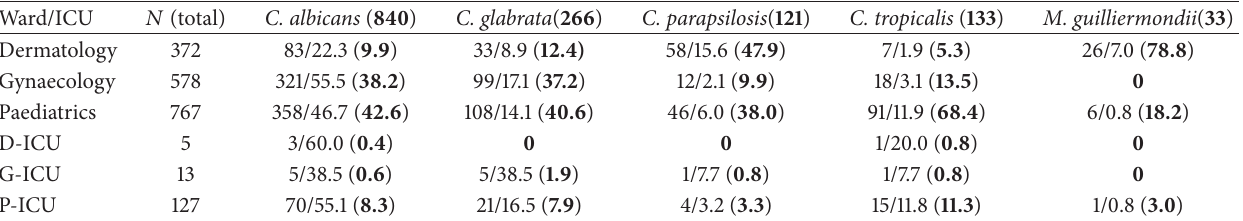
Table 3: Occurrence differences, respectively, of profiles of the most frequent isolated yeast species (number/percentage (% of species)) in the DGP wards and DGP